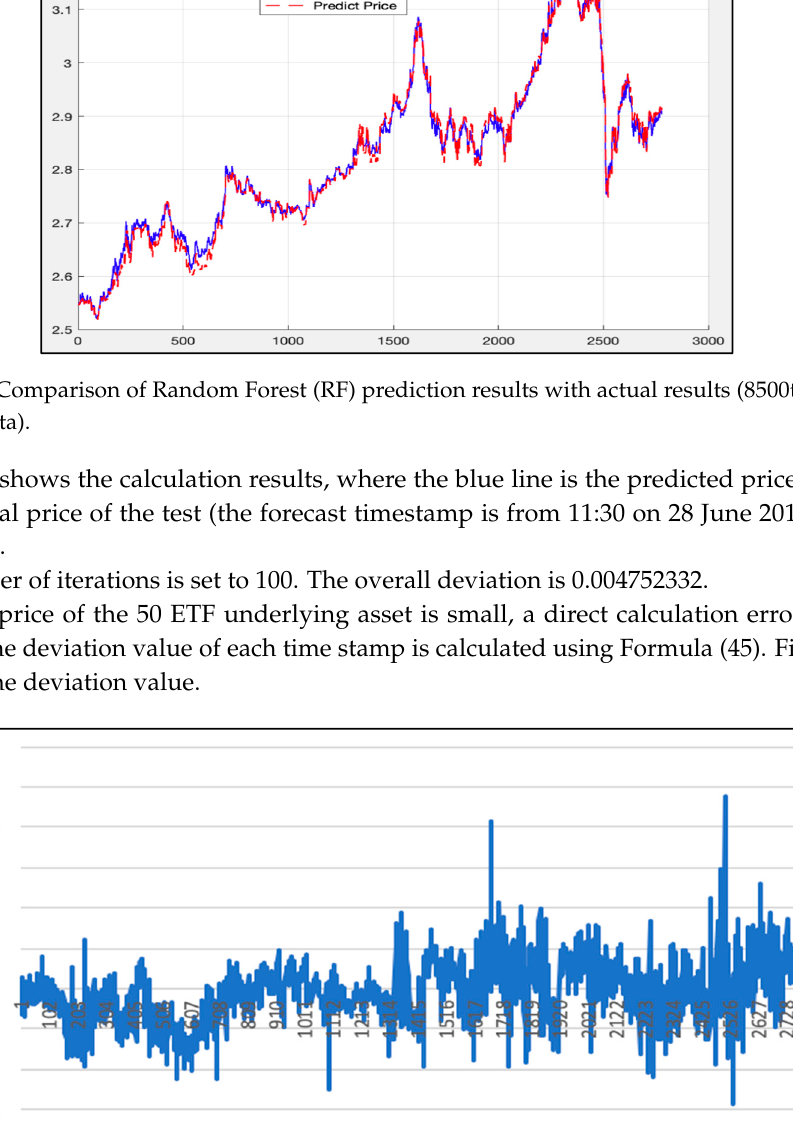
Algorithms 2019 , 12 , x FOR PEER REVIEW 22 of 35 Figure 16. Error map of LSTM prediction results and actual results (first 2850 data). As can be seen from Figure 16, the calculated statistics found that the change of a 27.7% error between the predicted data and the actual data is less than 1%, and that an 89.47% error is less than 5%. Comparing with the previous prediction, the deviation of the prediction results will increase when the market volatility increases. It can be drawn from Figures 13–16 that the error between the predicted value and the actual value obtained by the LSTM model is relatively stable; although the error will increase when the market is unstable, the extent of increase is not so large.